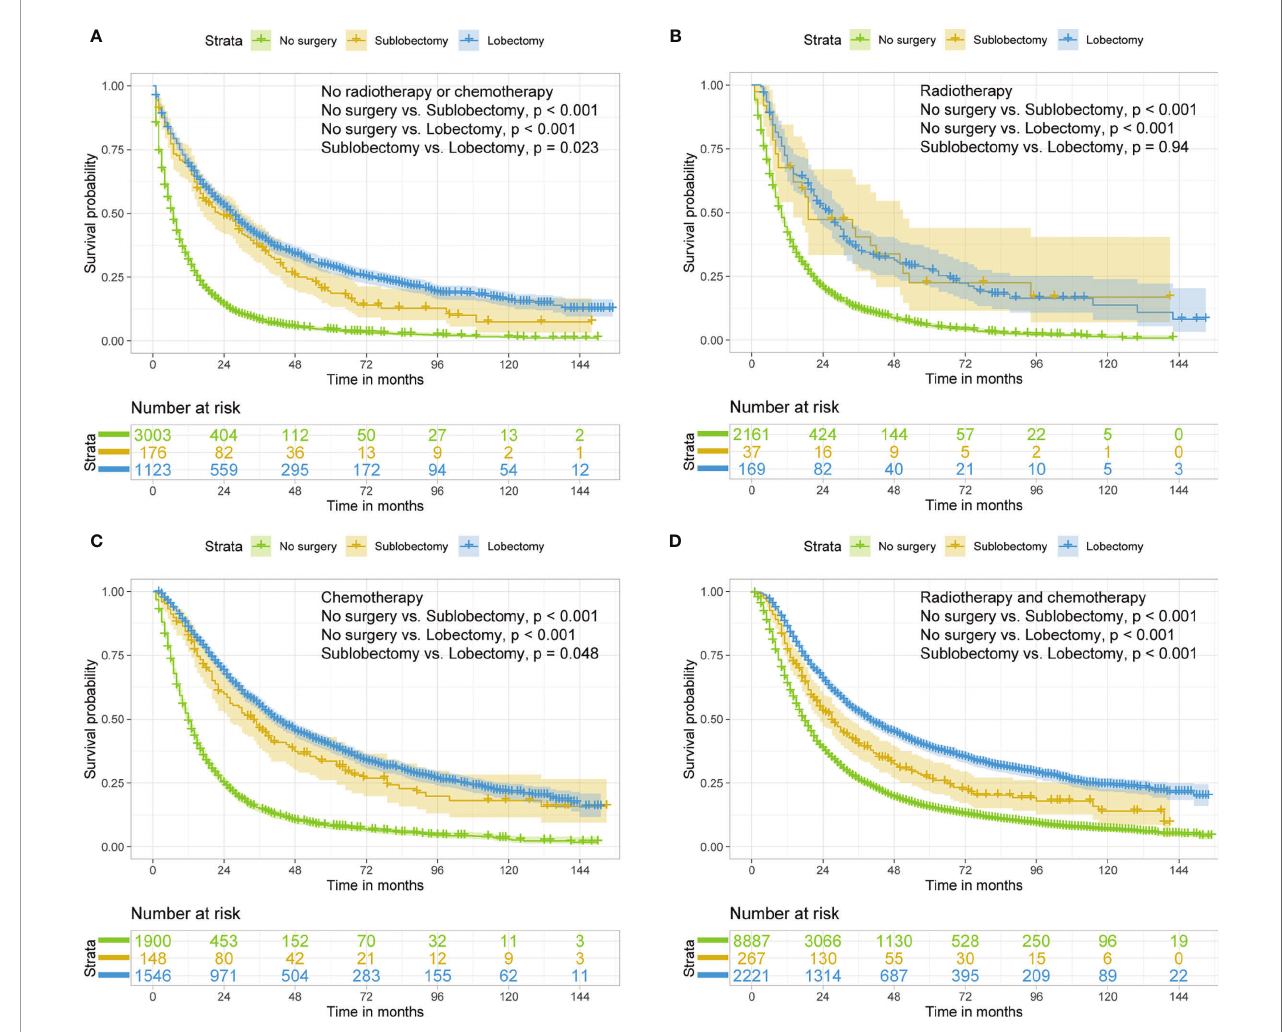
FIGURE 4 | Kaplan – Meier estimates of OS for stage IIIA/N2 NSCLC patients with no radiotherapy or chemotherapy (A) , radiotherapy (B) , chemotherapy (C) , radiotherapy and chemotherapy (D) strati fi ed by surgery strategy. OS, overall survival; NSCLC, non-small cell lung